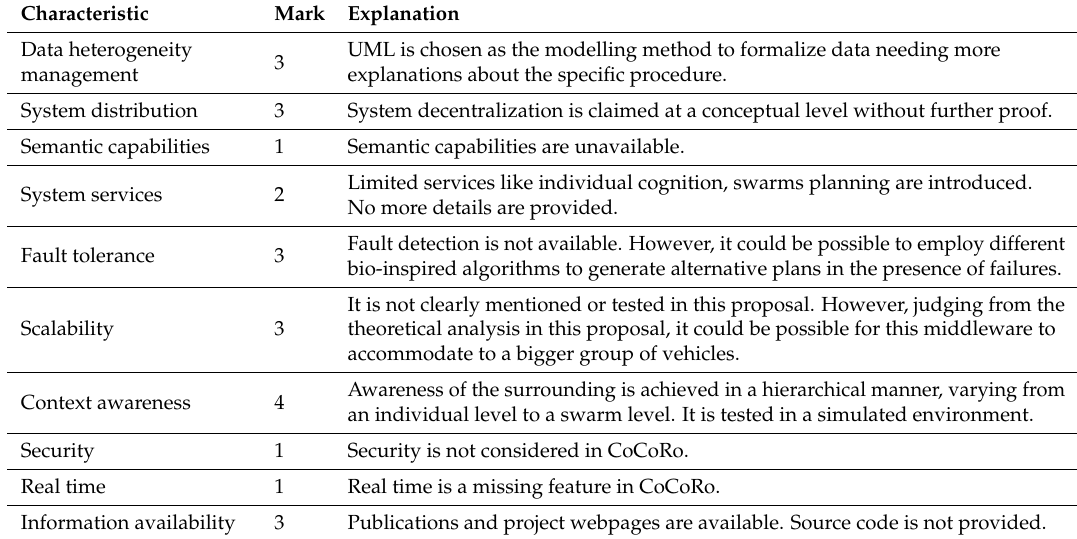
Table 18. CoCoRo assessment.